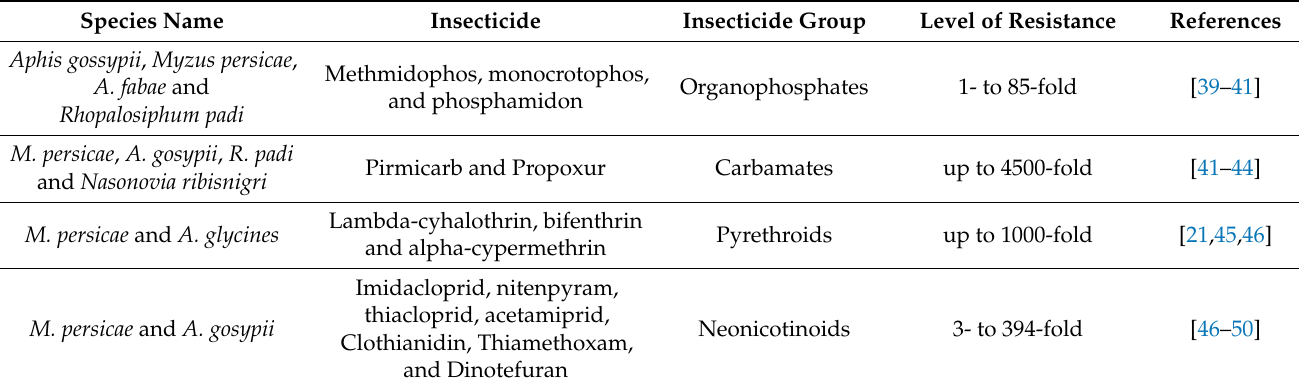
Table 1. Level of resistance in different species of aphids to various insecticide